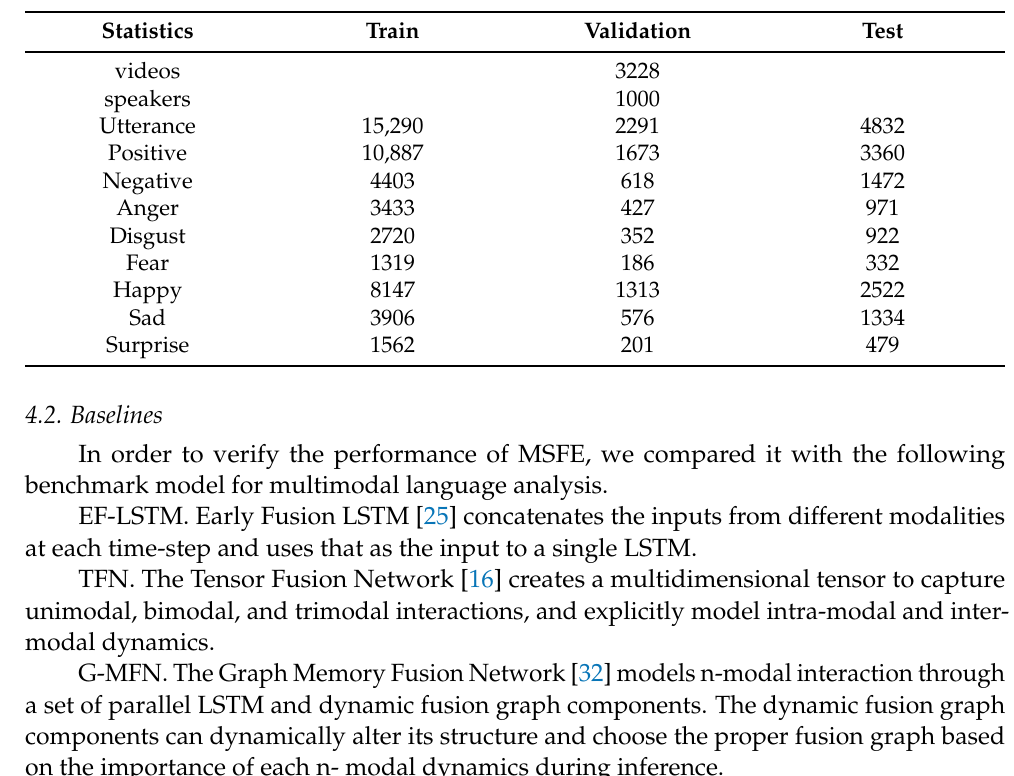
Table 1. Dataset statistics for CMU-MOSEI. Each utterance contains multimodal